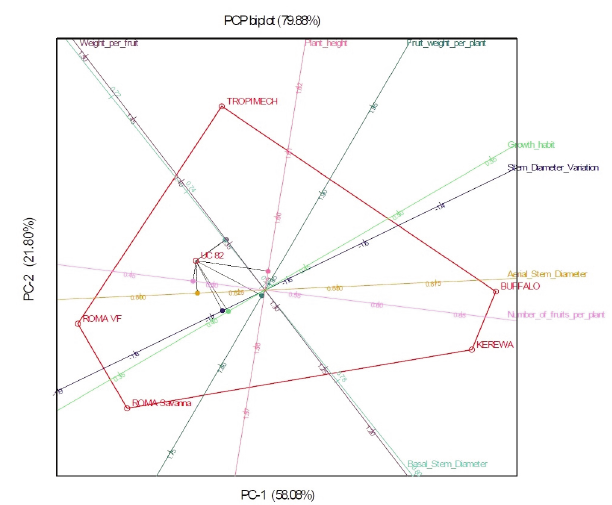
Fig. 3 ­ Principal Component’s biplot showing the differential performance of the tomato cultivars for the morphologi­ cal and yield